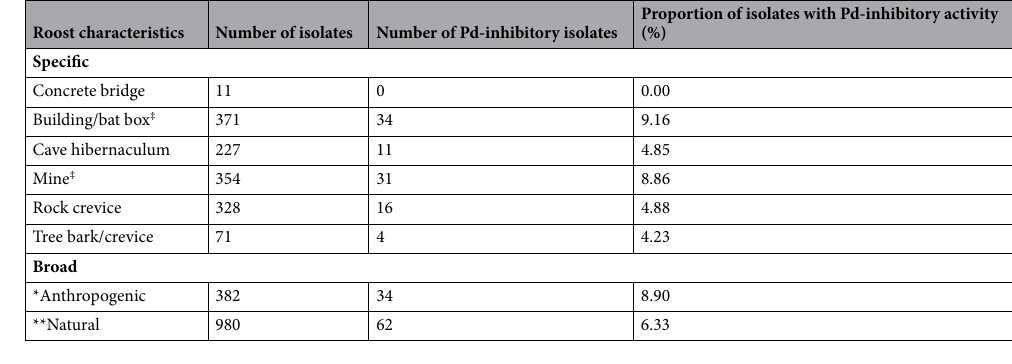
Table 4. The total number of isolates collected based on roosting characteristics. The roosting ecology was described based on the characteristics of roosts where bats were captured at or radio-tracked to, or were derived from potential roosting habitat observed in the area (see Table 3 for further breakdown). ‡ Although human-made, mines are rock substrates, as are caves; thus, mines were included in the natural habitat category. Bat boxes typically have plywood roosting chambers, and bats roost on various types of lumber/plywood in building roosts. *Anthropogenic: roosts heavily influenced by human activities. **Natural: roosts with relatively limited human influences.